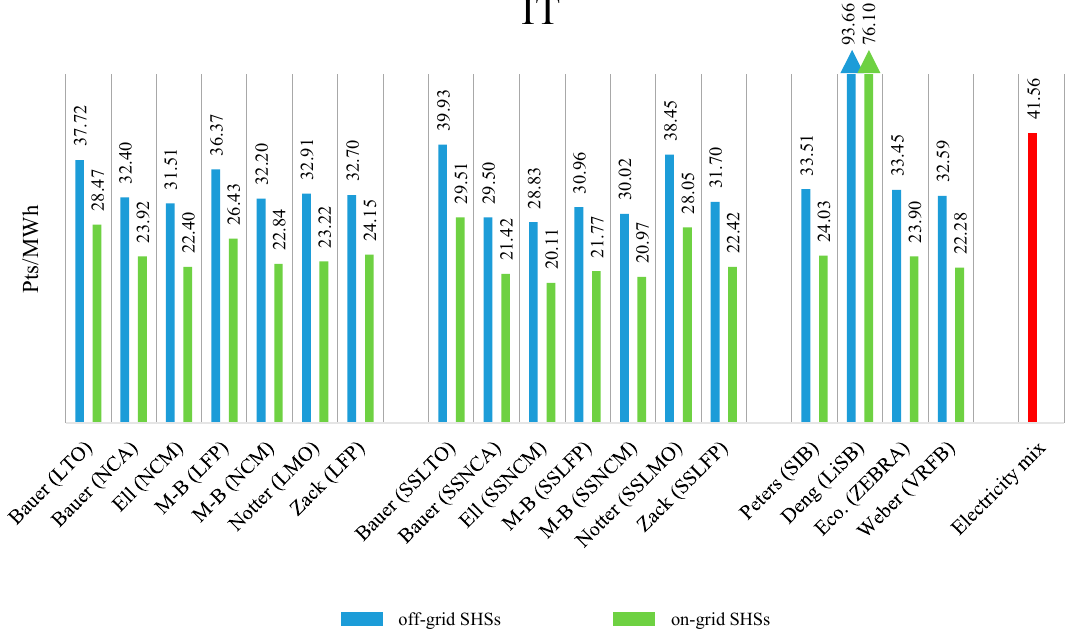
Figure 9. LCA impact values of SHSs in Hungary as single scores.